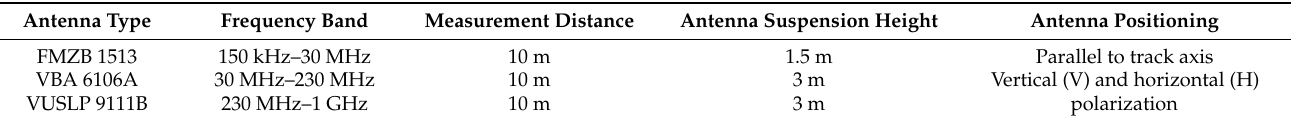
Table 1. Basic technical parameters of measuring antennas. Suspension height, distance, and position relative to the interfering object (source).